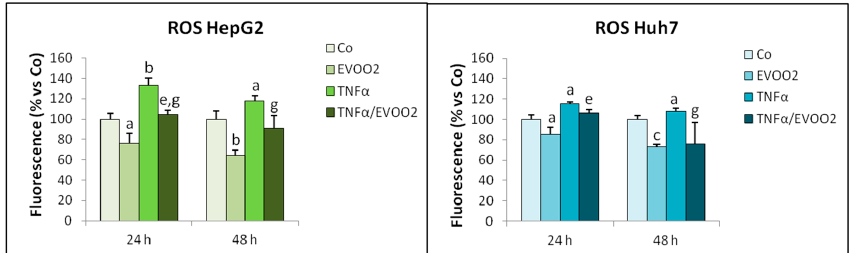
Figure 9. EVOO extract reduces basal ROS production. HepG2 and Huh7 cell lines incubated for 24 and 48 h with EVOO2 extract in the presence or absence of TNF α . The results are representative of three experiments. Data are presented as mean ± SD. (a: p < 0.05, b: p < 0.01, c: p < 0.001 versus Control; e: p < 0.01 versus EVOO; g: p < 0.05 versus TNF α ).